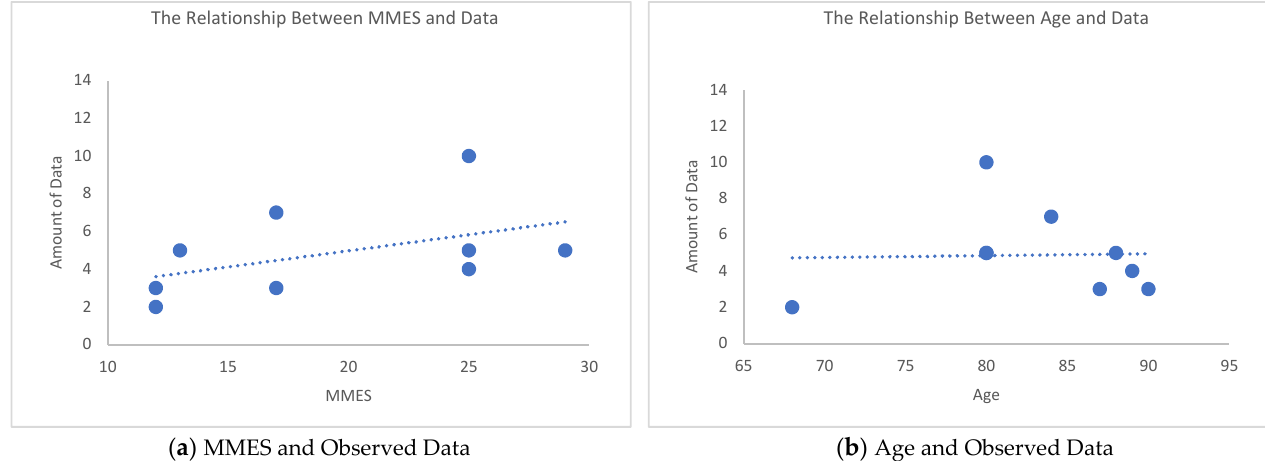
Figure 8. MMES, age, and the number of observed data. NC, and X means the group with LC.